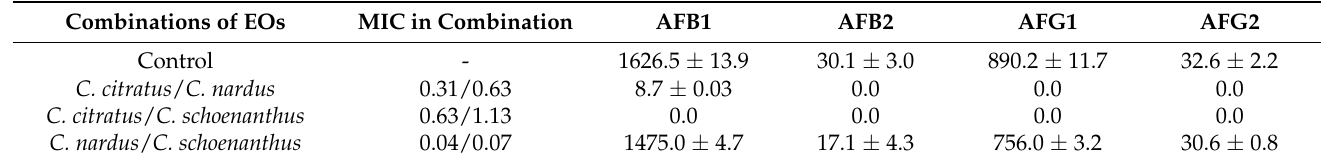
Table 10. Effect of essential oil pair combinations on the production of aflatoxin B1, B2, G1, and G2 ( µ